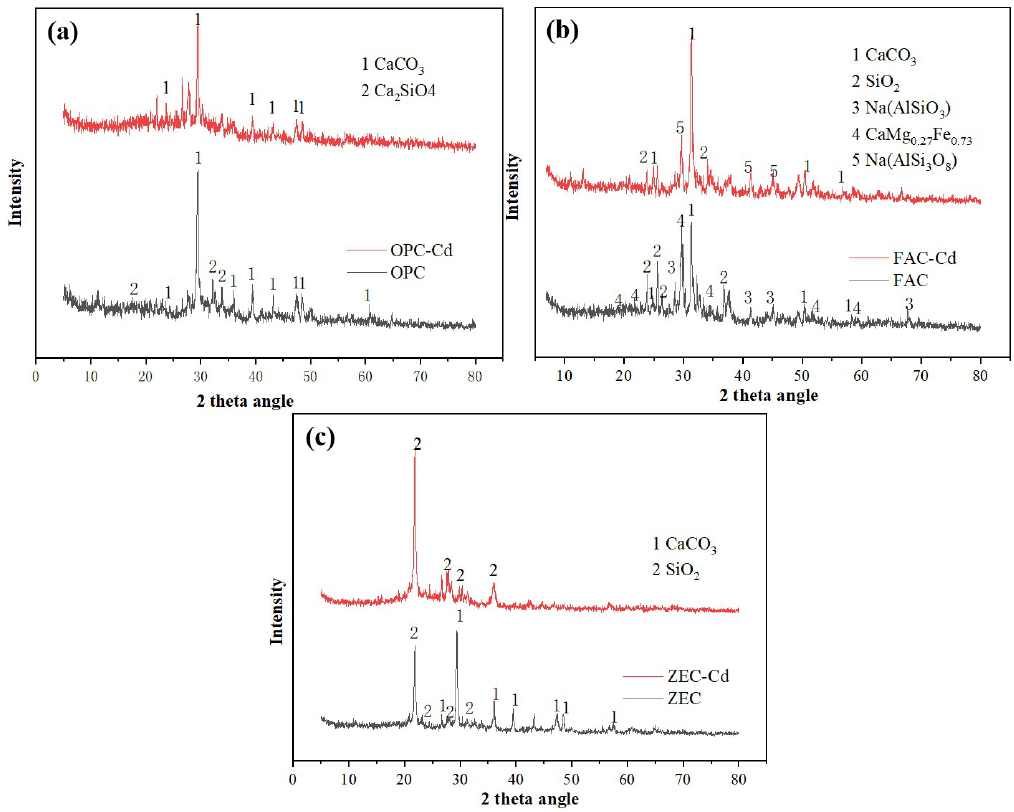
Figure 1. X-ray diffraction spectra for ( a ) cement paste (OPC), ( b ) fly ash cement (FAC) paste, and ( c ) zeolite cement (ZEC) paste before and after adsorption of Cd 2+ .